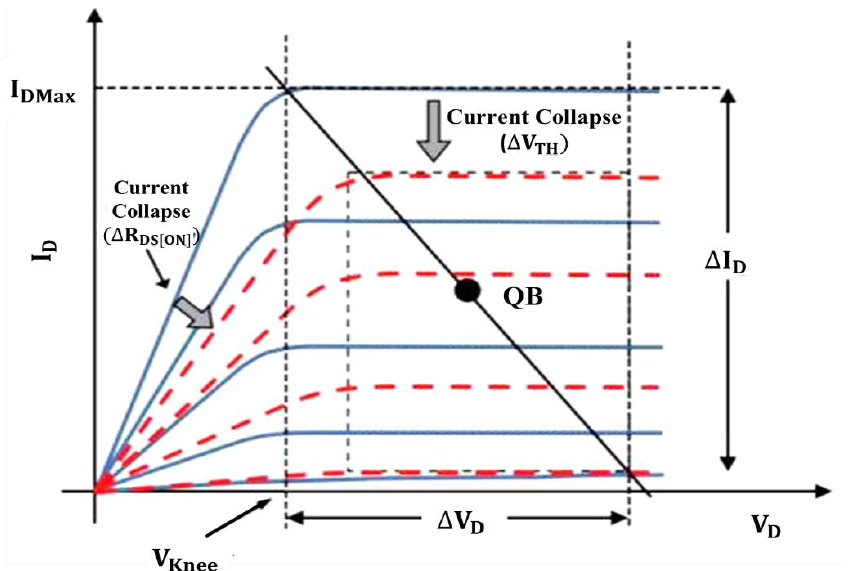
Figure 29. The I D – V D characteristics curve of HEMT before (solid lines) and after (graded lines) current collapse is shown in this diagram. Reprinted with permission [152], Copyright 2003, the American Vacuum Society.